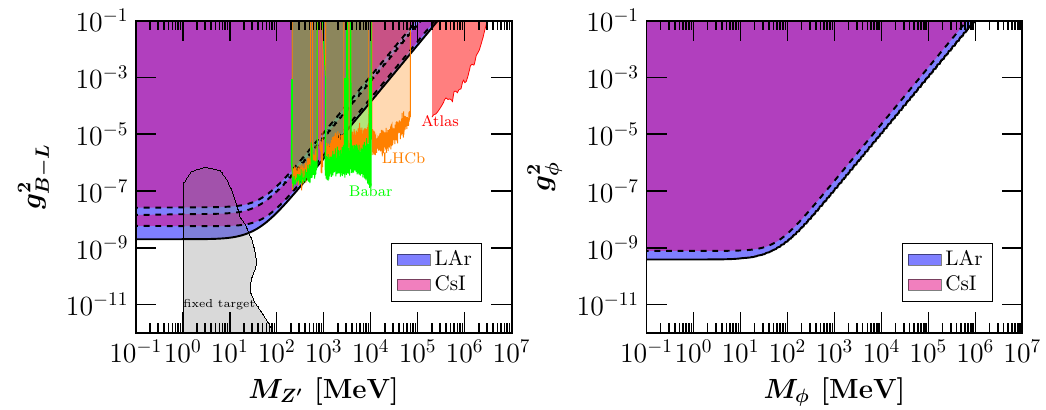
Figure 7 . Excluded region at 90% C.L in the parameter space ( M Z 0 ; g 2 scenario (left) and ( M (cid:8) ; g 2 ) for the scalar mediator scenario (right), from the analysis of the recent (cid:8) LAr data. In both cases, a comparison is given with the CsI